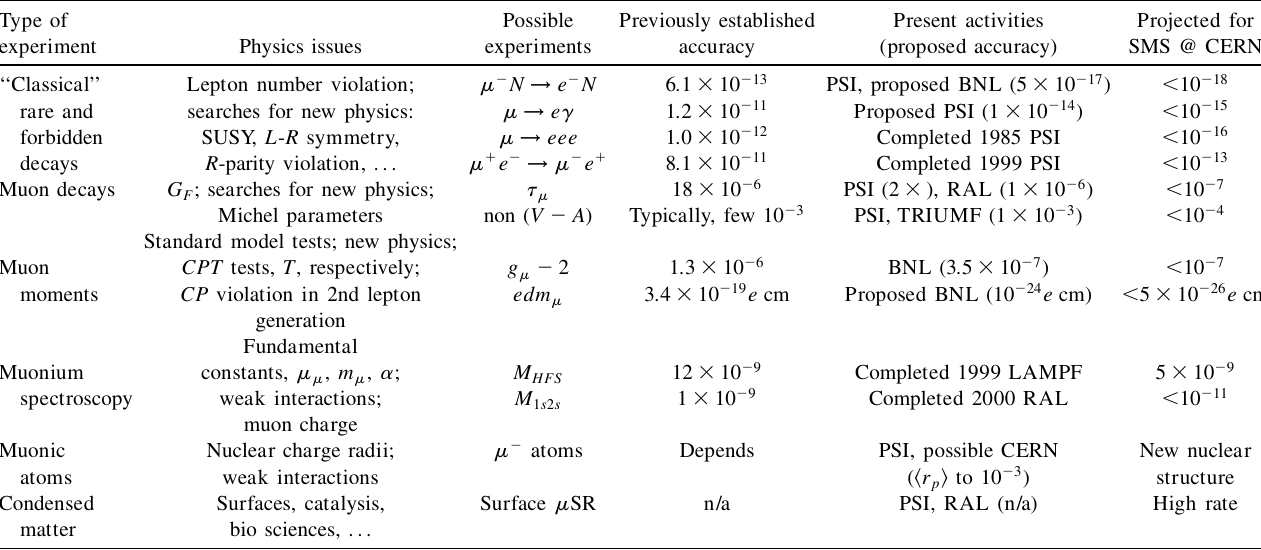
TABLE II. Experiments which could beneficially take advantage of the intense future stopped muon source. The numbers were worked out for scenarios at a future stopped muon source (SMS) of a neutrino factory at CERN [87]. They are based on a muon flux of 10 21 particles per annum in which beam will be available for 10 7 s . Typical beam requirements are given in Table III. Type